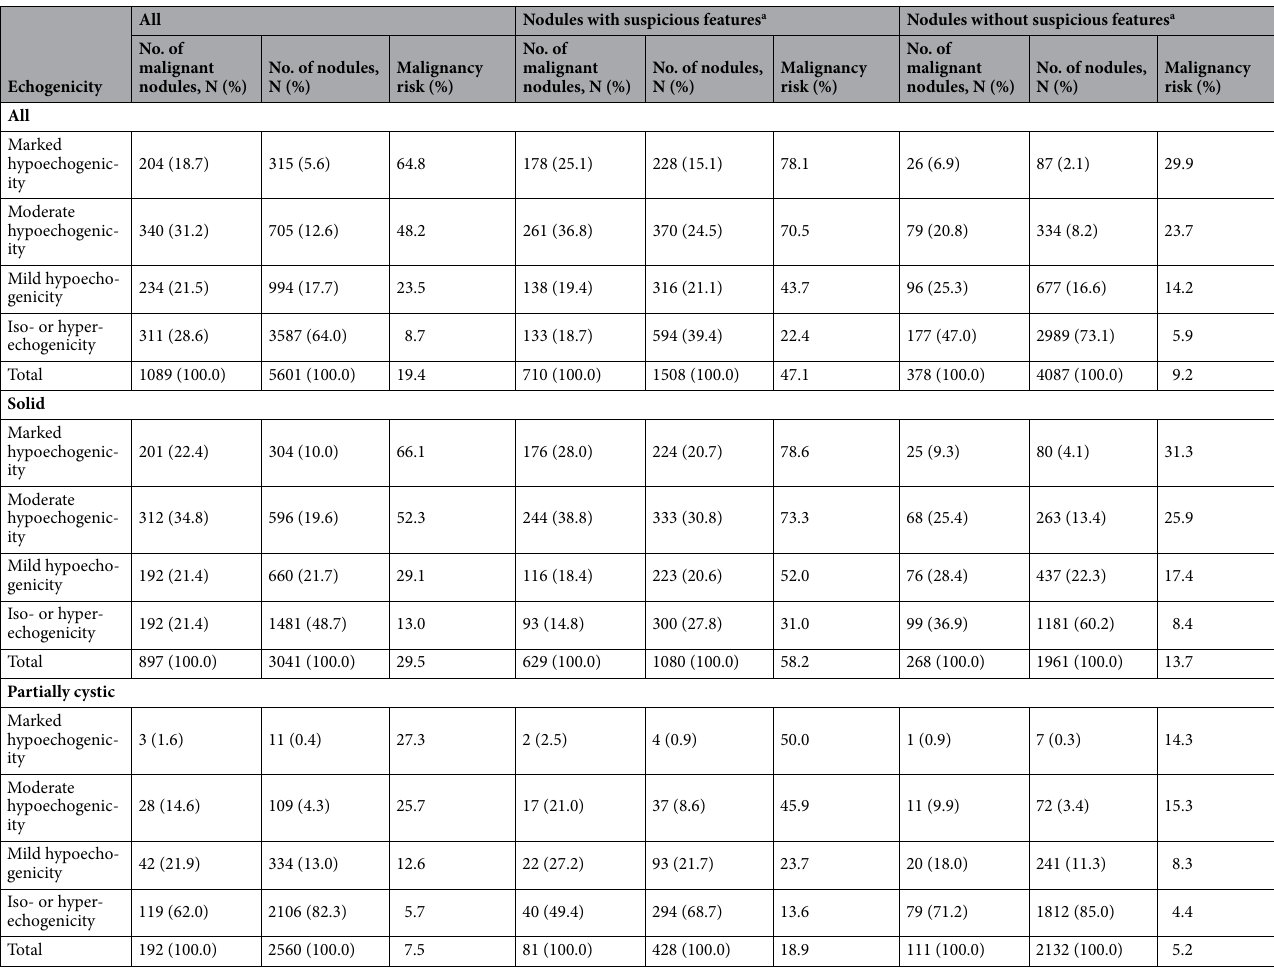
Table 3. Malignancy Risk Stratified by Degree of Hypoechogenicity and Predominant Echogenicity According to Composition and suspicious Features. a Suspicious US features include punctuate echogenic foci, nonparallel orientation (taller than wide) and irregular